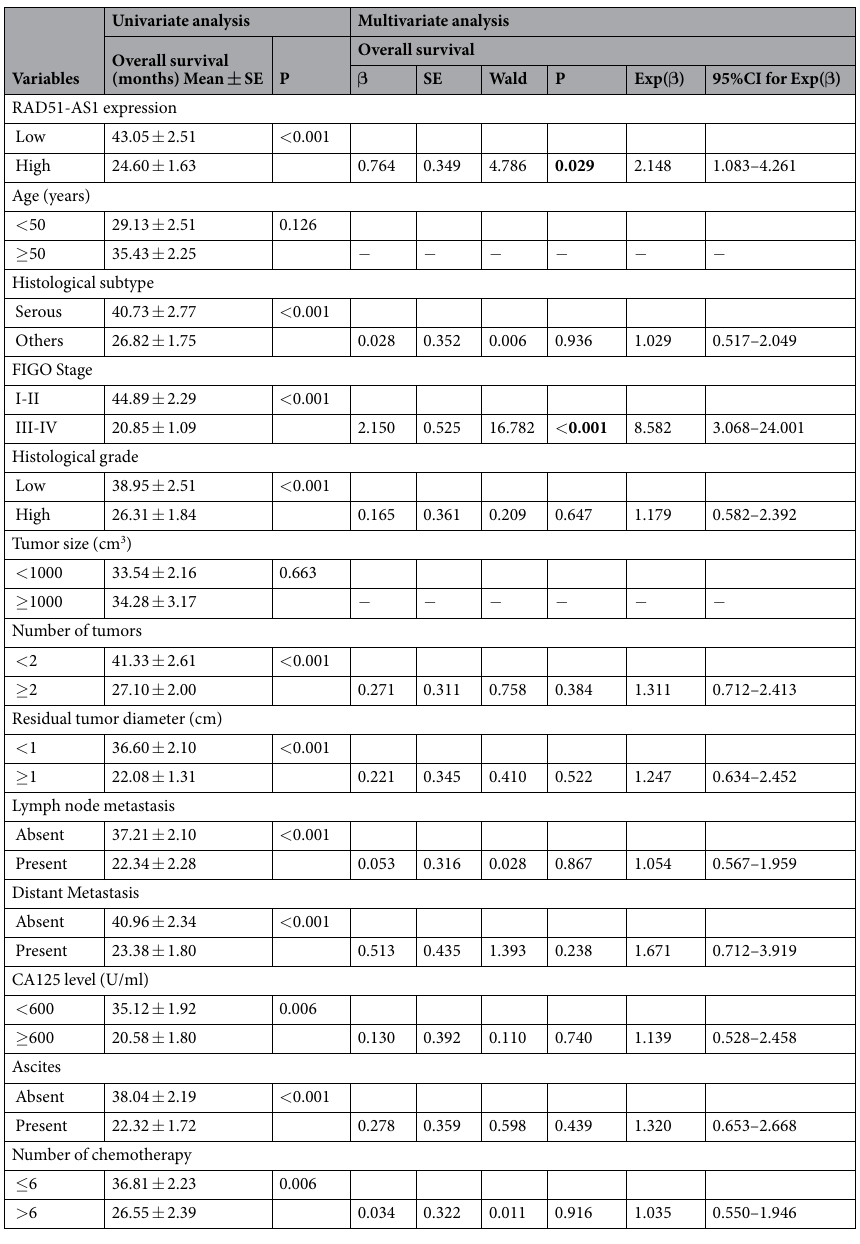
Table 2. Univariate and multivariate analysis of overall survival in 106 EOC patients. All tests were two-sided, and P < 0.05 was considered